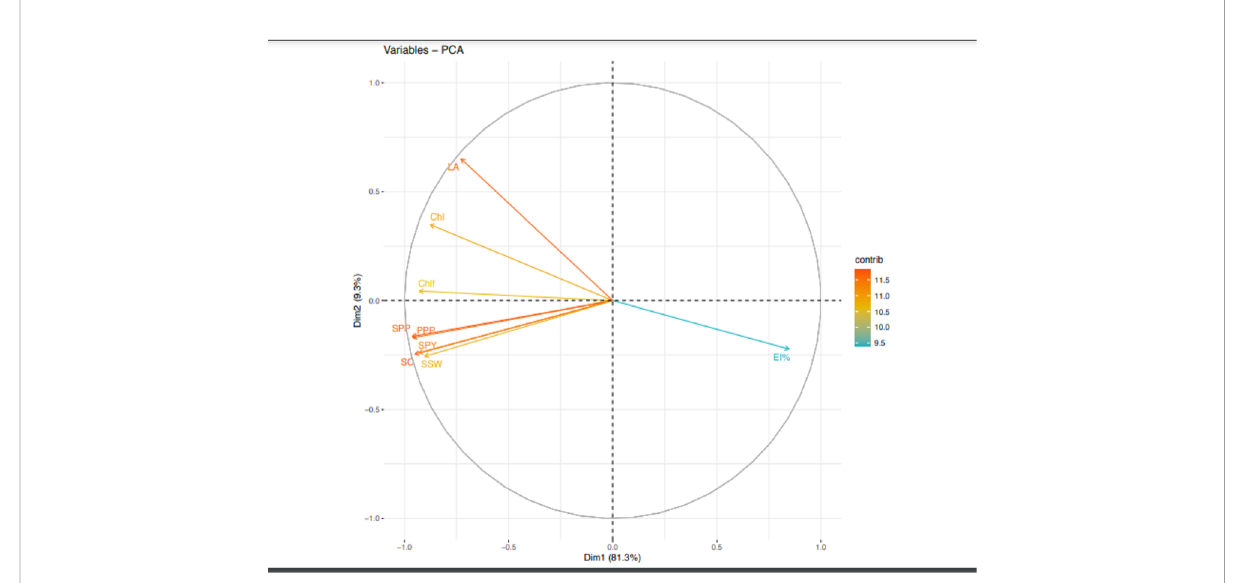
FIGURE 6 Principal component analysis (PCA) of various traits in urdbean genotypes under heat stress in the year